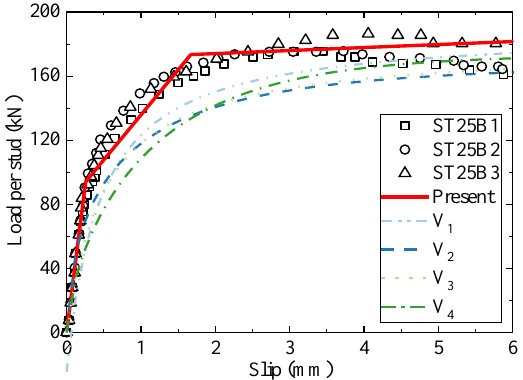
Figure 10. The comparison of load–slip curves between the test, empirical formulae, and the analytical method for ST25B1-3.